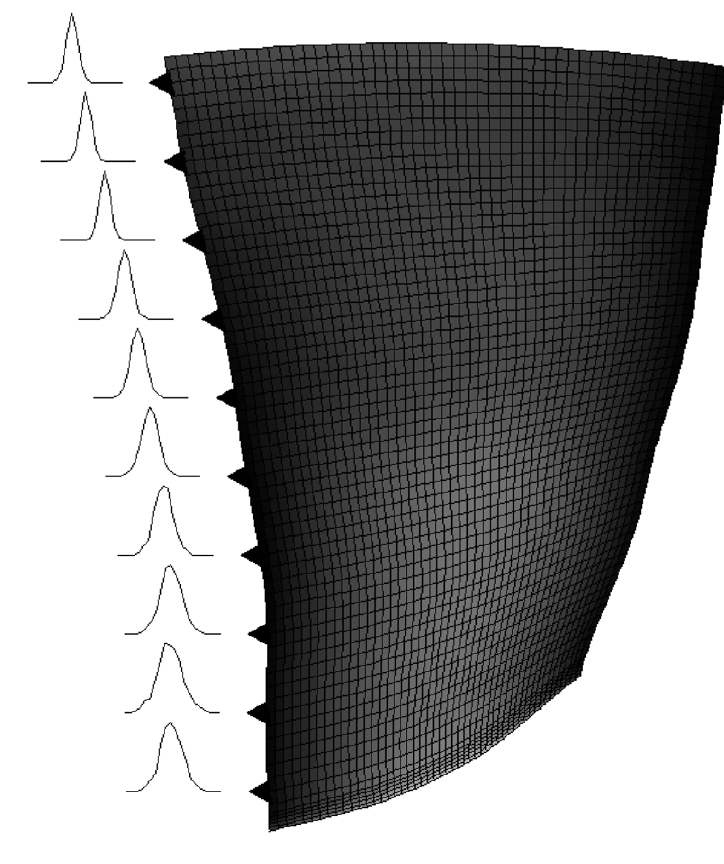
Fig. 6. Stress distributions at leading edge